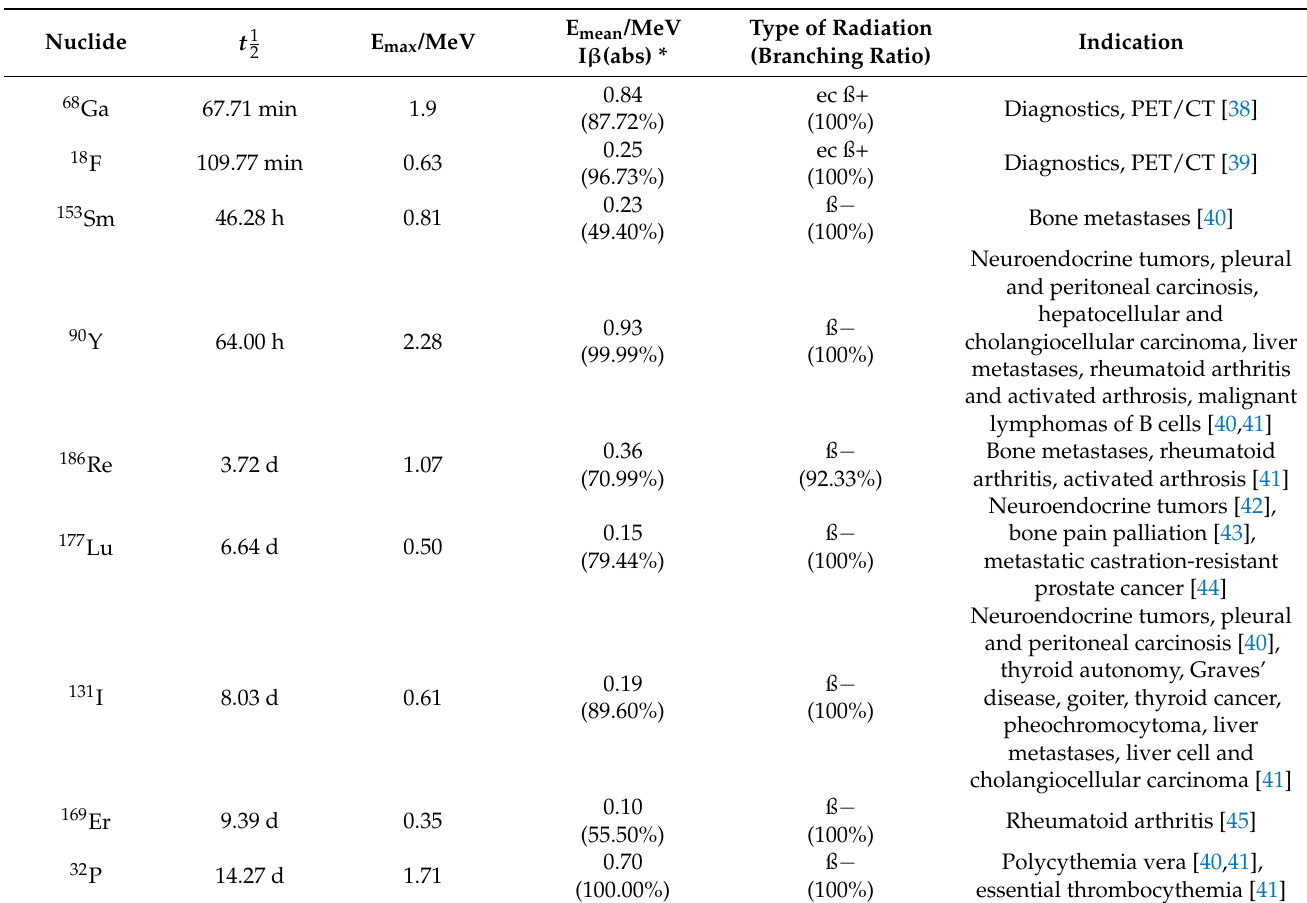
Table 1. Parameters of selected radionuclides with clinical significance [36]. Every positron-emitting (ß+) nuclide results in electron capture (ec). This is another mode of beta decay in which an electron is captured by the atomic nucleus [37]. I β (abs) *: absolute β − or β + intensity in